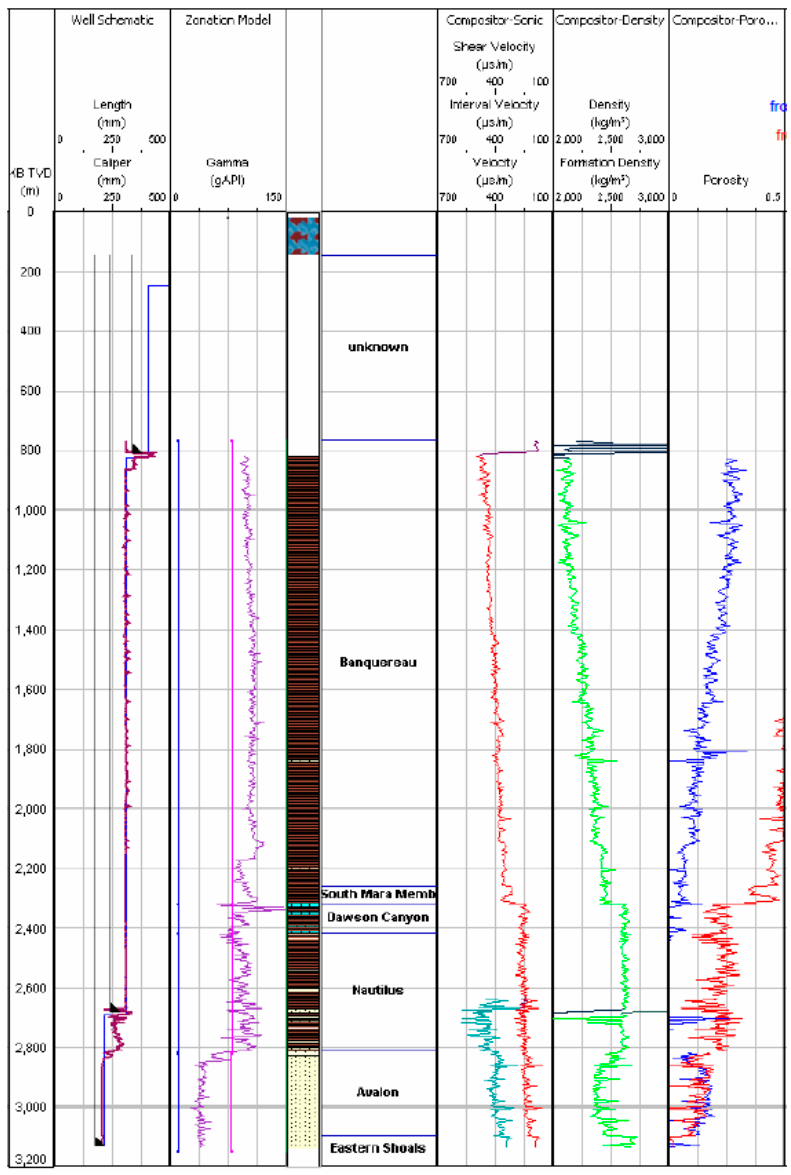
Figure 27. Well N-8 compressional (Vp) and shear wave (Vs) velocities.